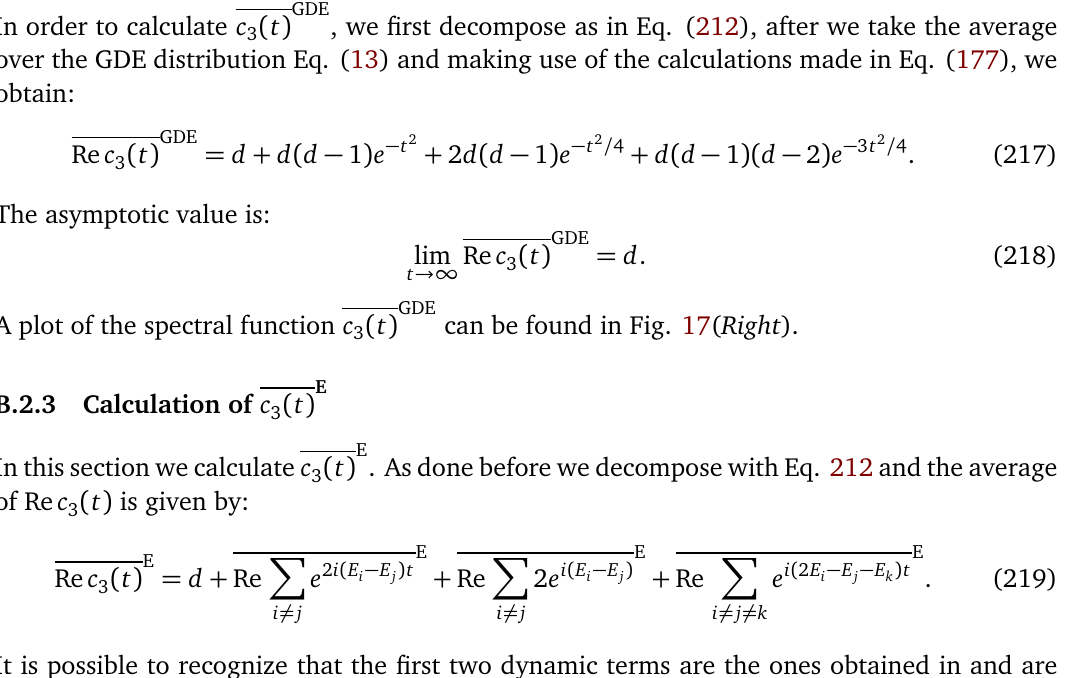
Figure 17: Left : Plot of the normalized Re c GUE ensemble for different system size d = 2 N with N = 6,...,16. Right : Plot of the rescaled spectral function ˜ c different system size d = 2 N with N =